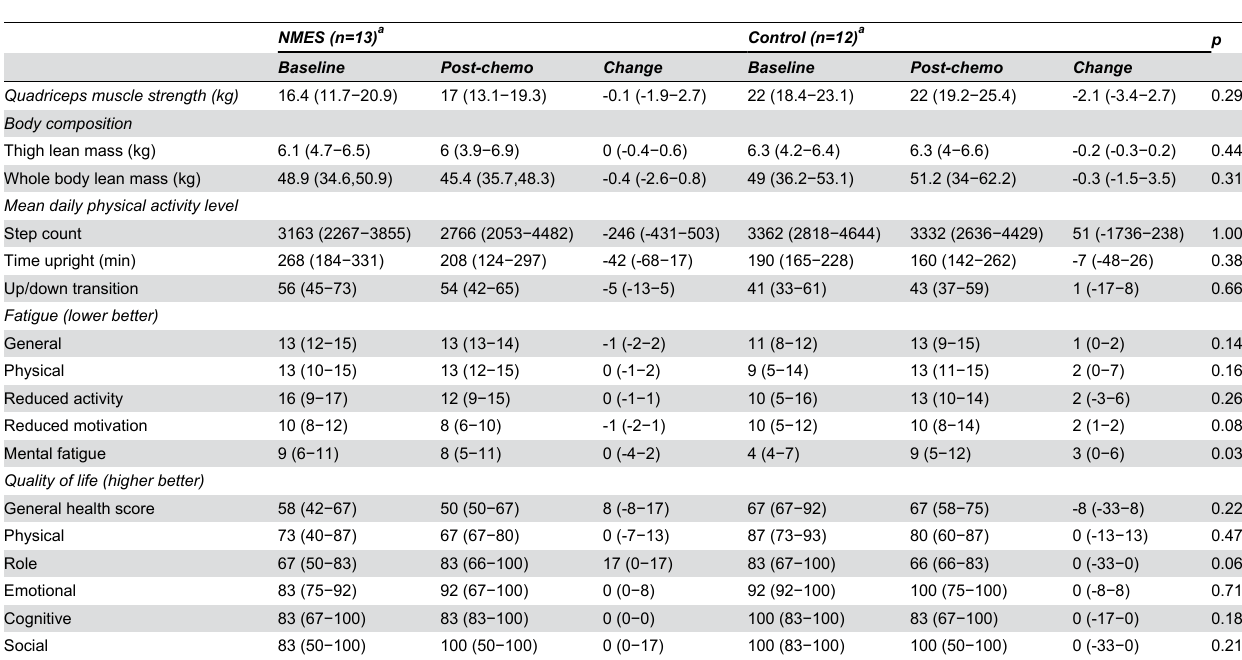
Table 2. Secondary outcomes expressed as median (IQR) (exploratory per-protocol